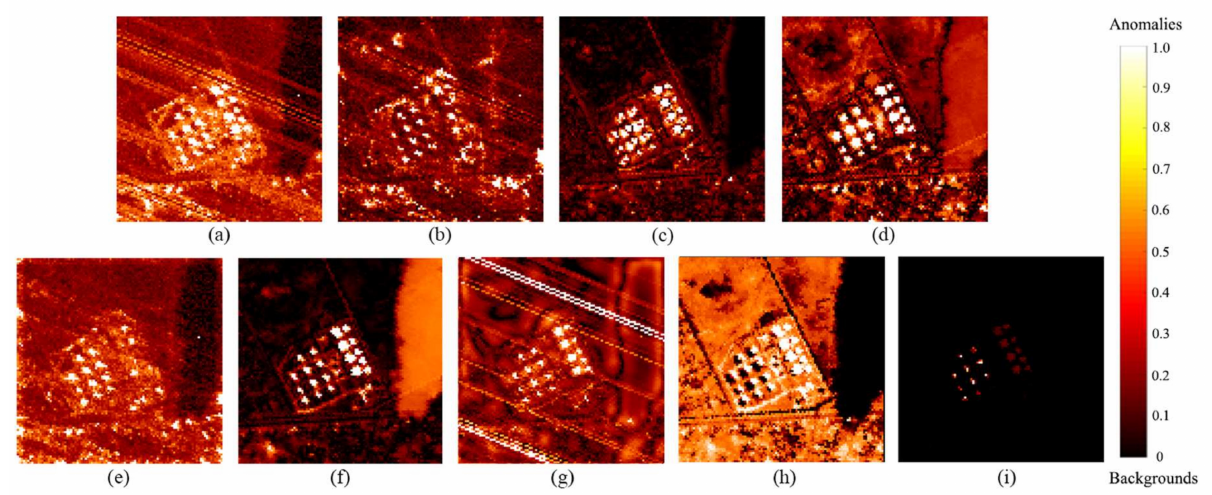
Figure 5. Detection results of the various algorithms for the Texas Coast Image: ( a ) RX, ( b ) LRX, ( c ) KRX, ( d ) SSRX, ( e )